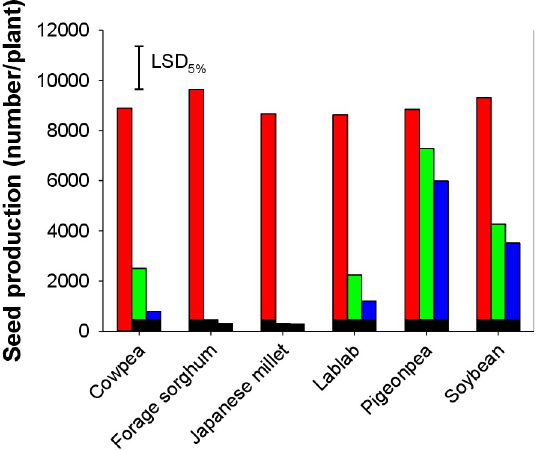
Fig 5. Seed production by Echinochloa colona when it was grown alone or in interference with 80 and 160 plants m -2 of various cover